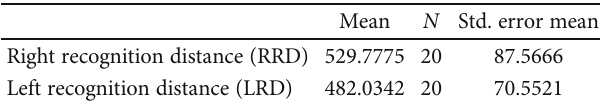
Figure 7: Recognition of the reconstructed images (JAFFE). Table 1: Sample statistics of the recognition distance.